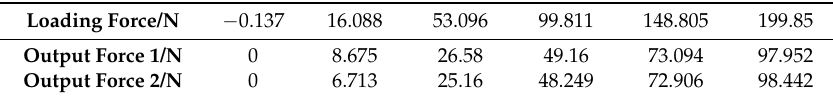
Table 3. Experiment 3 (the weight is 106.8 kg).